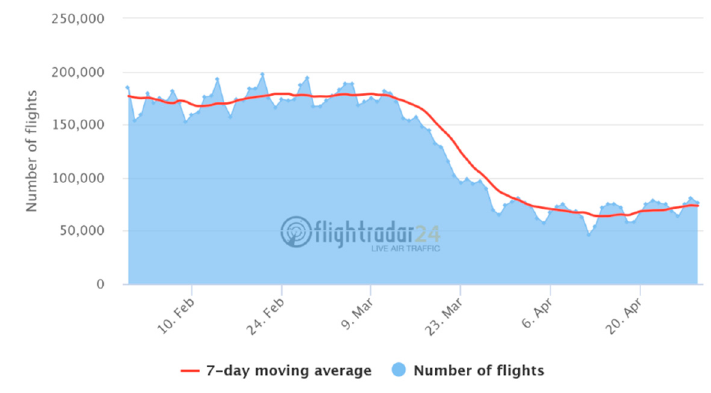
Figure 4. Commercial flights tracked by Flightradar24 between 31 January and 29 April 2020. Source: https://www.flightradar24.com/data/statistics.